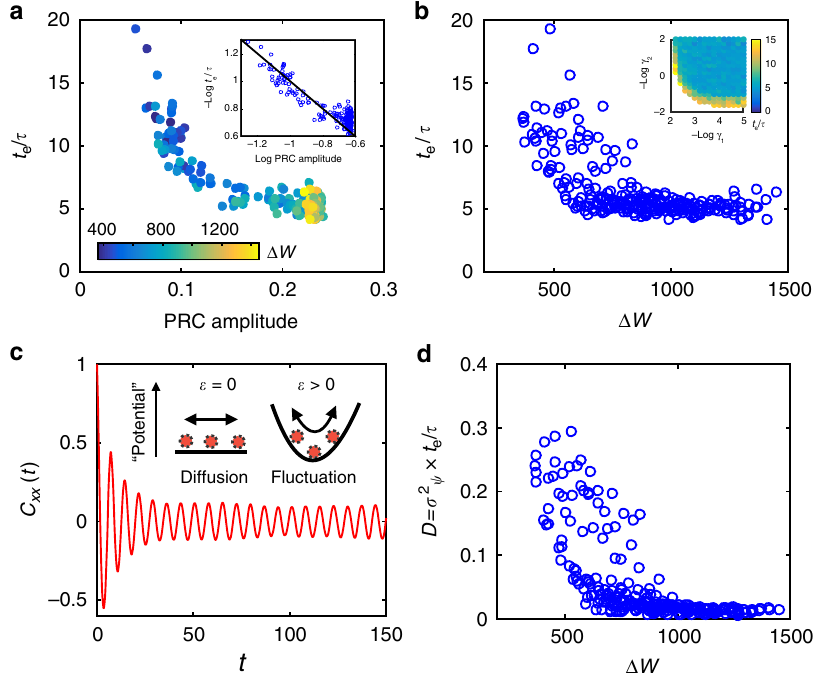
Fig. 4 Relation between entrainment performance and phase sensitivity and free-energy dissipation. a The minimum number of cycles needed for entrainment t e / τ versus the PRC amplitude for different choices of ( γ 1 , γ 2 ). The energy dissipation per period Δ W is shown by the color of the data points. The log-log plot in the inset clearly shows t e / τ scales inversely with the PRC amplitude. b t e / τ decreases with Δ W . The inset shows t e / τ (represented by ; (cid:2) log γ the color) in the ð(cid:2) log γ space. c Autocorrelation function C xx ( t ) versus time t . The amplitude fi rst decays exponentially and then reaches a 1 2 Þ constant e (cid:2) Dt e in agreement with Eq. (10). The phase dynamics in the cases without ( ϵ = 0) and with ( ϵ > 0) external driving signal are illustrated in the inset. d The phase diffusion constant D , inferred from phase variance, decreases with the energy dissipation Δ W . The external driving signal strength ϵ = 0.1 for all